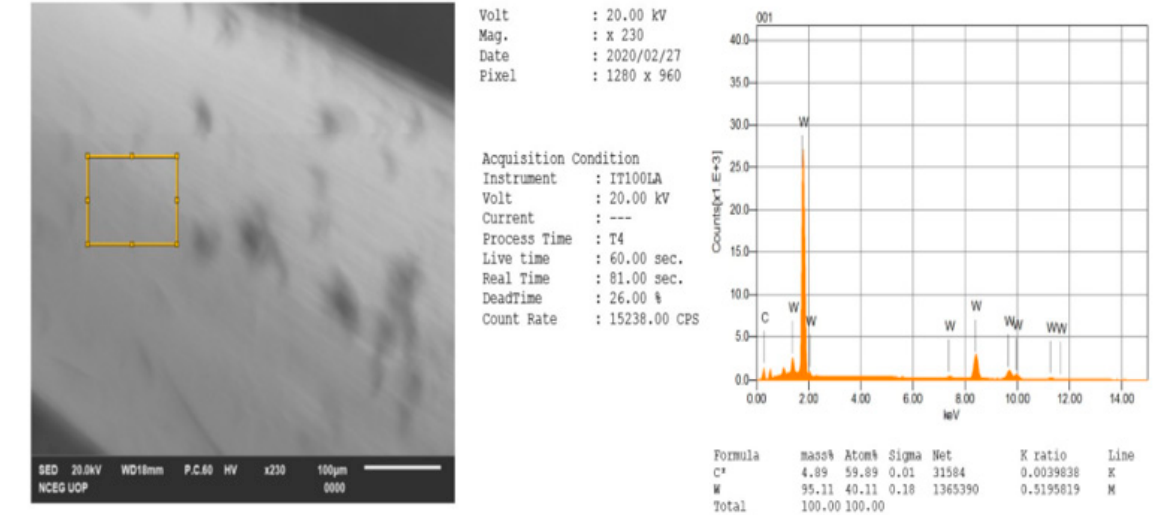
Figure 11. EDX results for a tungsten tip after removal of contamination.